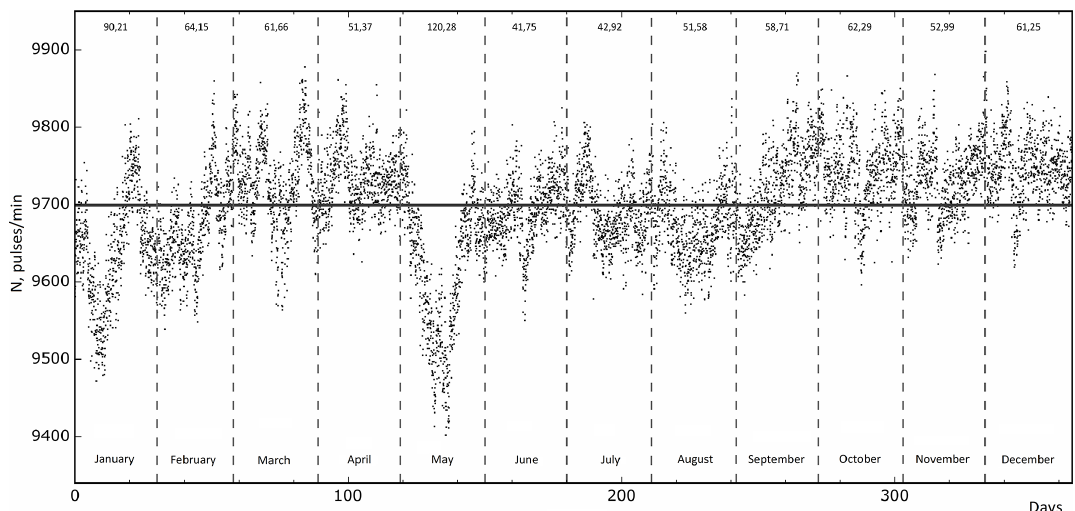
Figure 3. Pressure-corrected count rate variations of the Moscow neutron monitor for the period of 2019. The horizontal line is the average count rate. The vertical dashed lines are the boundaries of the months. The standard deviations for the data of each month are shown at the